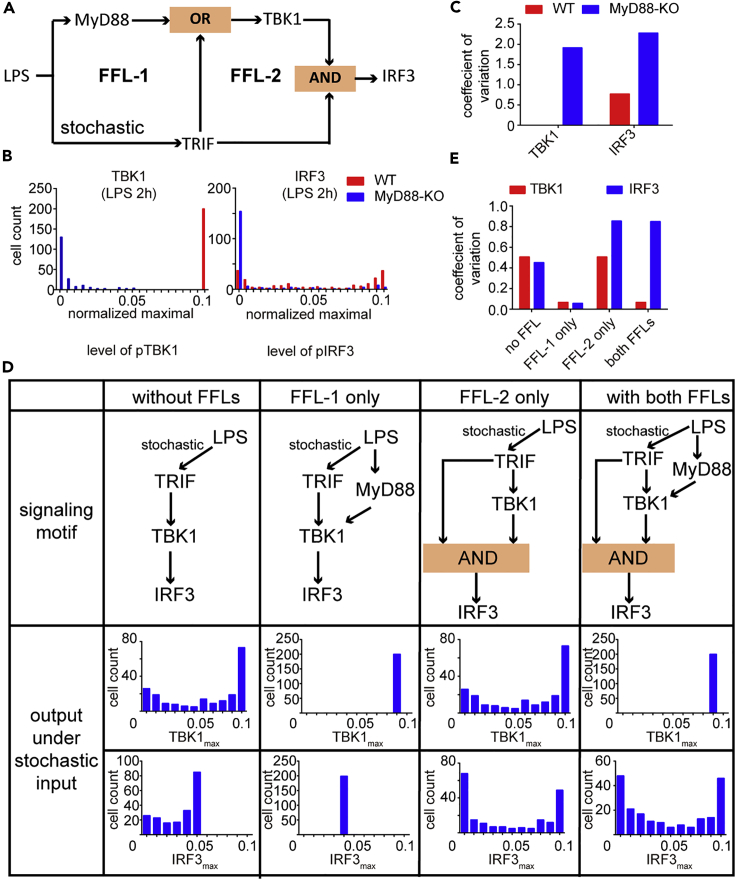
Dual C1-FFLs Shape the Heterogeneity of the Activities of Key Molecules in TLR4 Signaling Pathway(A) Schematic representation of feedforward loops (FLLs) within TLR4 signaling pathway; whole pathway of TLR4 signaling was shown in Figure S4A.(B and C) Maximal levels of activated TBK1 and IRF3 under LPS stimulation were simulated with or without MyD88 in silico (B), and coefficients of variation (CV) of TBK1 and IRF3 activation were calculated (C).(D and E) Maximal levels and coefficient of variation of TBK1 and IRF3 were compared under stochastic activation of TRIF in models with or without FFL-1 and FFL-2.See also Figure S4 and Tables S7 and S8.